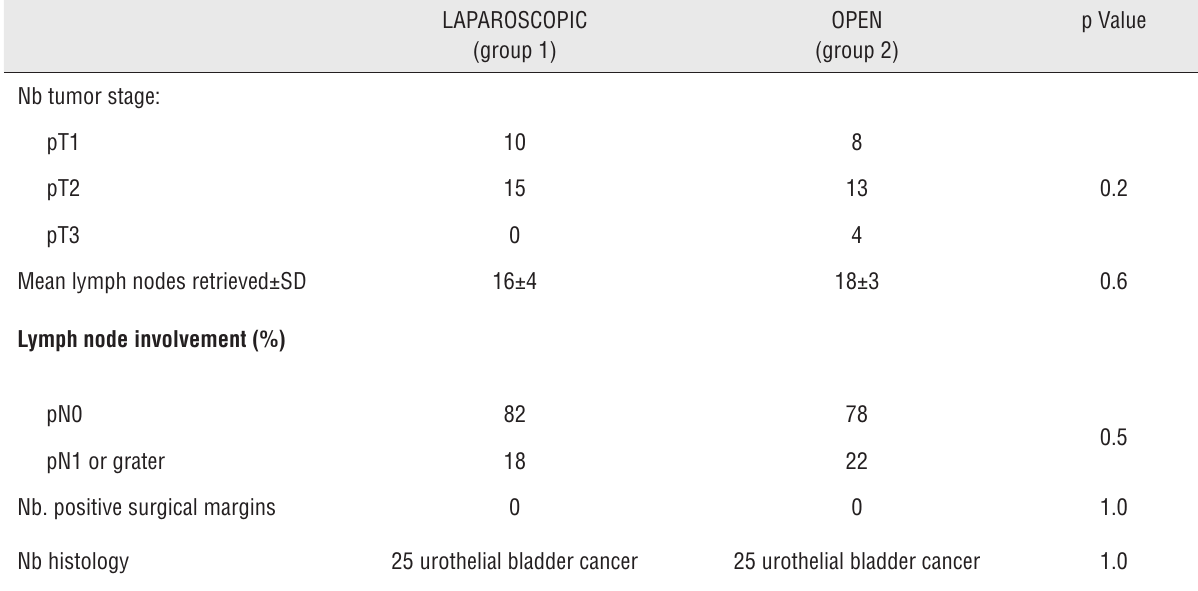
Table 2 - Postoperative histopathological